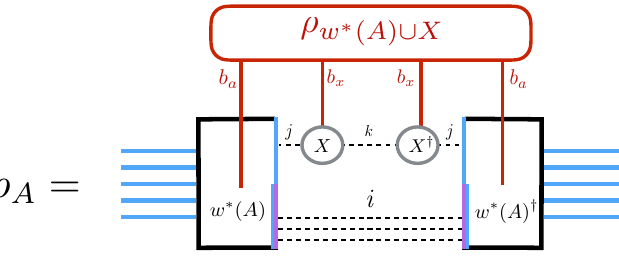
(cid:22) A ) de(cid:12)nes